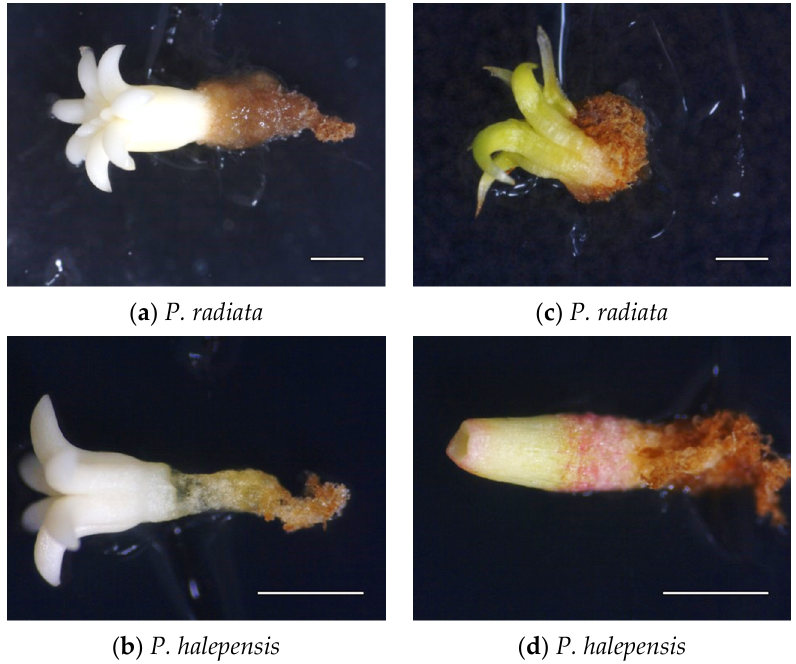
Figure 1. Somatic embryos showing distinct morphologies: ( a ) normal somatic embryo (NNE) for Pinus radiata D.Don; ( b ) normal somatic embryo (NNE) for Pinus halepensis Mill . ; ( c ) abnormal somatic embryo (NAE) for P. radiata ; ( d ) abnormal somatic embryo (NAE) for P. halepensis , bar = 2 mm.